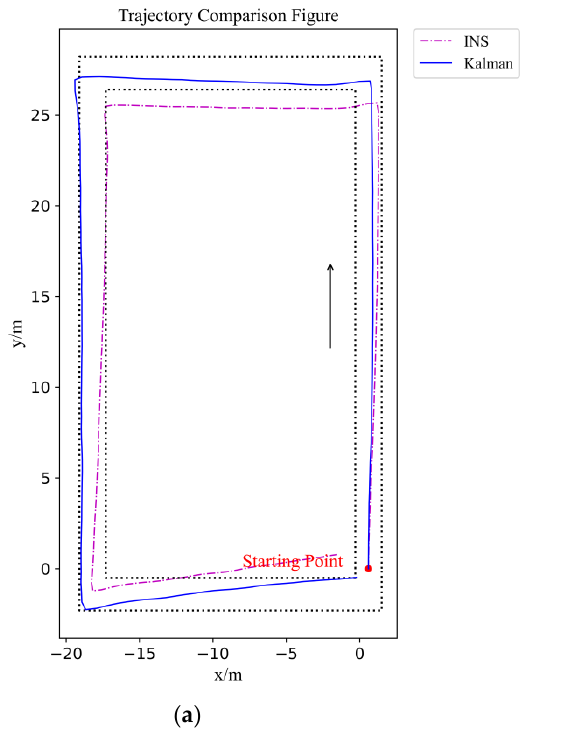
Table 2. Errors of INS positioning algorithm.